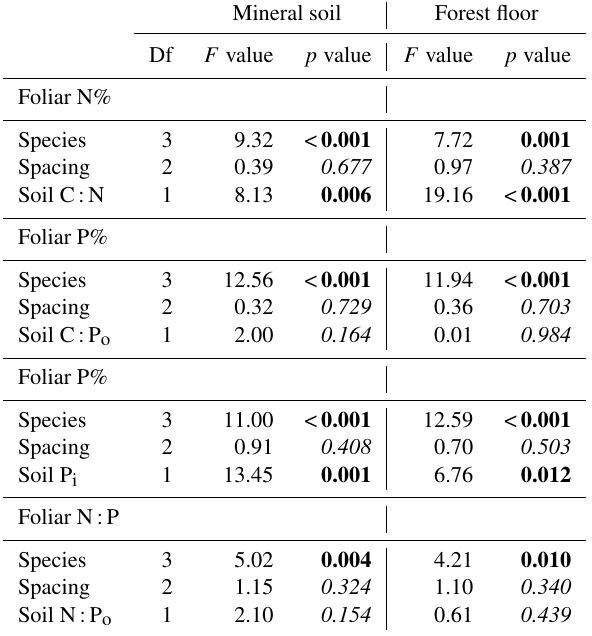
Table 4. Conifer species foliar nitrogen (N) and phosphorus (P) concentrations and molar N:P ratios in relation to planting den- sity (1329, 748 and 479 stemsha − 1 ) and mineral soil (0–20cm) or forest floor resource stoichiometry (as molar ratio; p values<0.05 in bold). Mineral